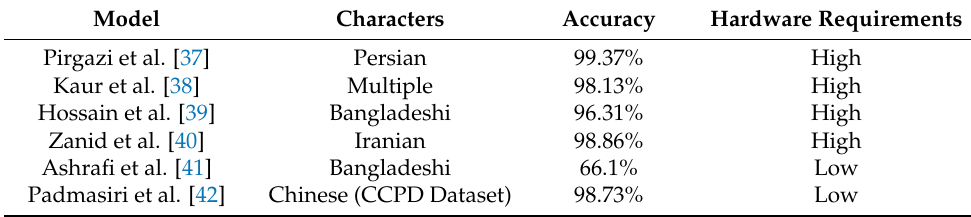
Table 1. Example of up-to-date solutions for license plate recognition.